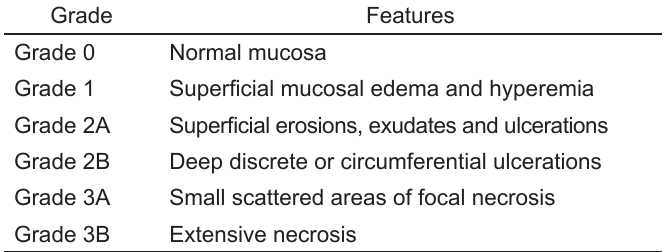
Table. Endoscopic grading of esophageal injuries (reproduced from Zargar et al, 2